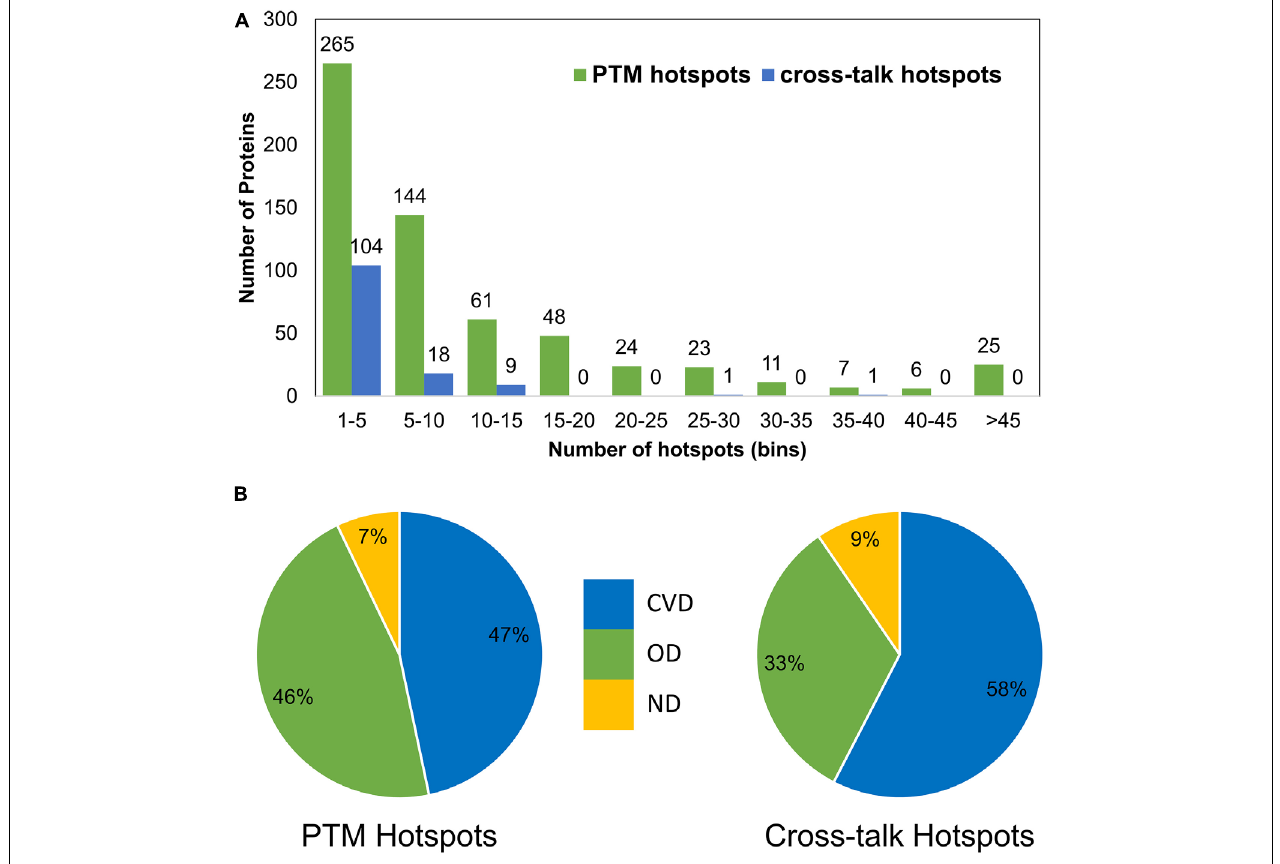
FIGURE 6 | Post-translational modification and crosstalk hotspots in sirtuin interactors. (A) Frequency of proteins in each hotspot bin. (B) Disease category distribution in PTM hotspots (left) and crosstalk hotspots (right) shows their occurrence in CVDs and other diseases. While PTM hotspots have similar association with CVDs like OD, the crosstalk hotspots show much higher association